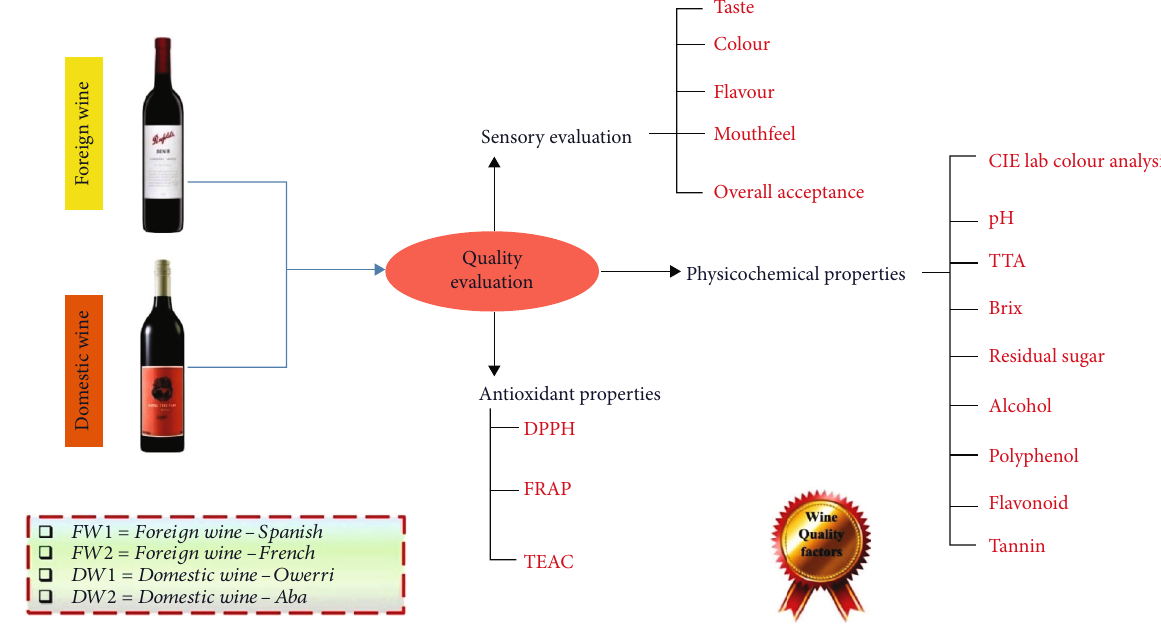
Figure 1: Schematic overview of the experimental